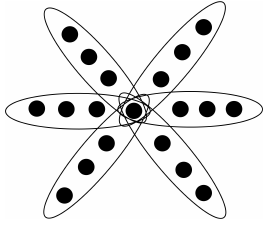
Figure 1. Hyperstar S 4